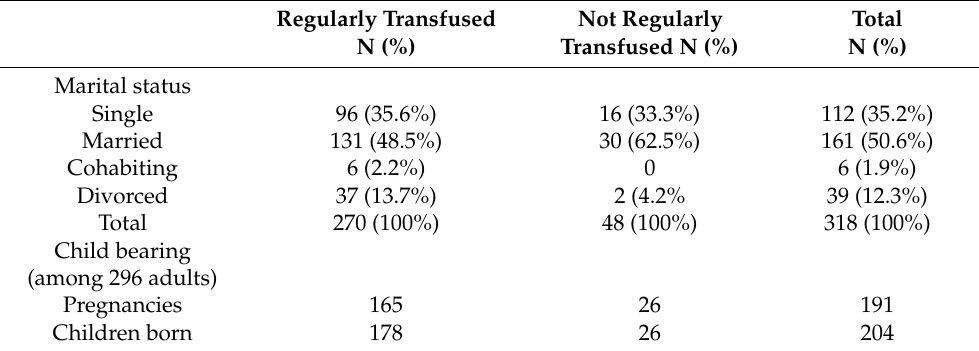
Table 5. Marital status and child bearing in patients with thalassaemia in Cyprus according to transfusion